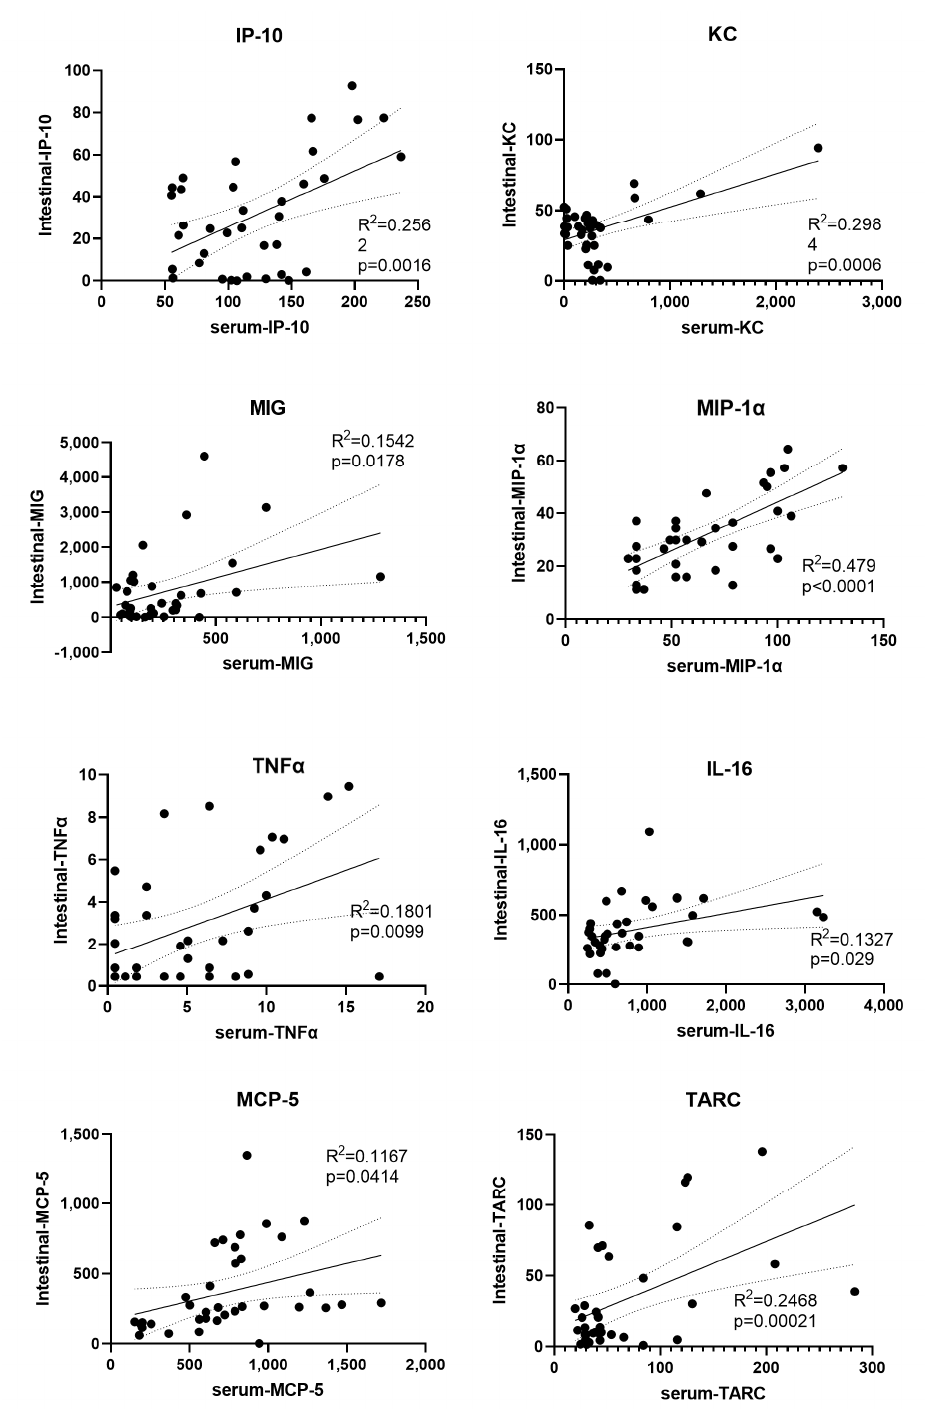
Figure 8. Significantly correlated cytokines between serum and intestine. Pearson’s correlation analysis was performed. Each dot represented one mouse. Pearson’s correlation coefficient ( R 2 ) and p values for each cytokine were shown on each graph. Black line was the linear regression line and dotted lines represented the 95% confidence intervals of the linear regression